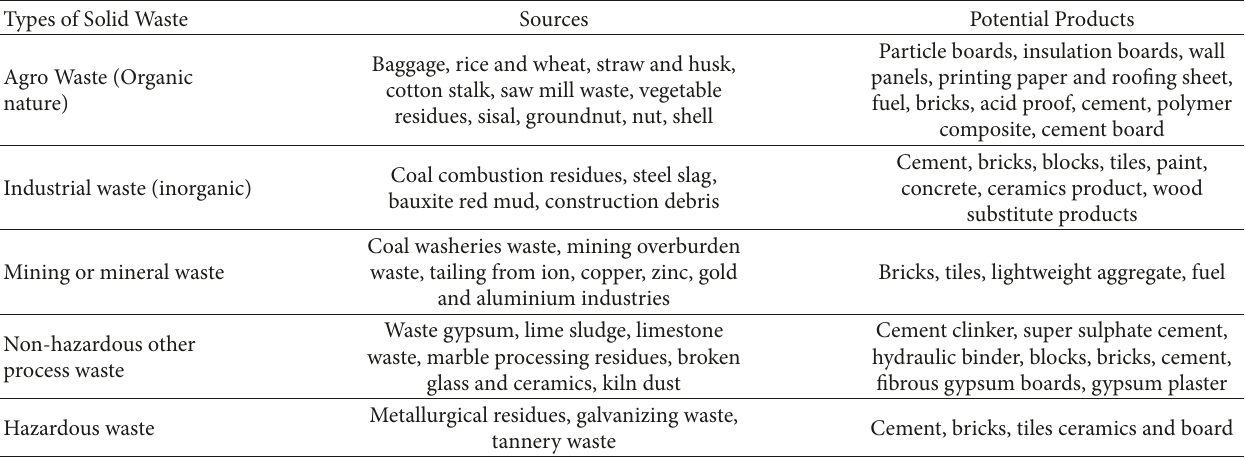
Table 2: Types and nature of solid wastes and their recycling and utilization